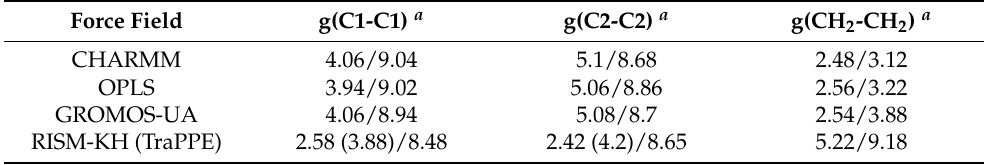
Table 2. First and second maxima of the RDFs from the MD simulations and the partial distribution functions (in Å) from the RISM-KH calculation of liquid 1,9-decadiene.